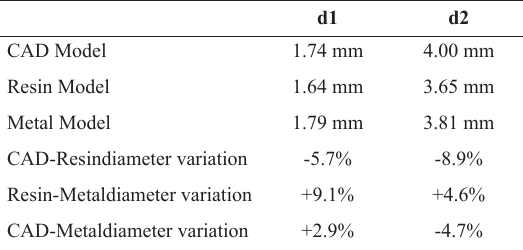
Table 7. Measurements for the diameters d1, d2 and their variation percentage for the various productions steps.